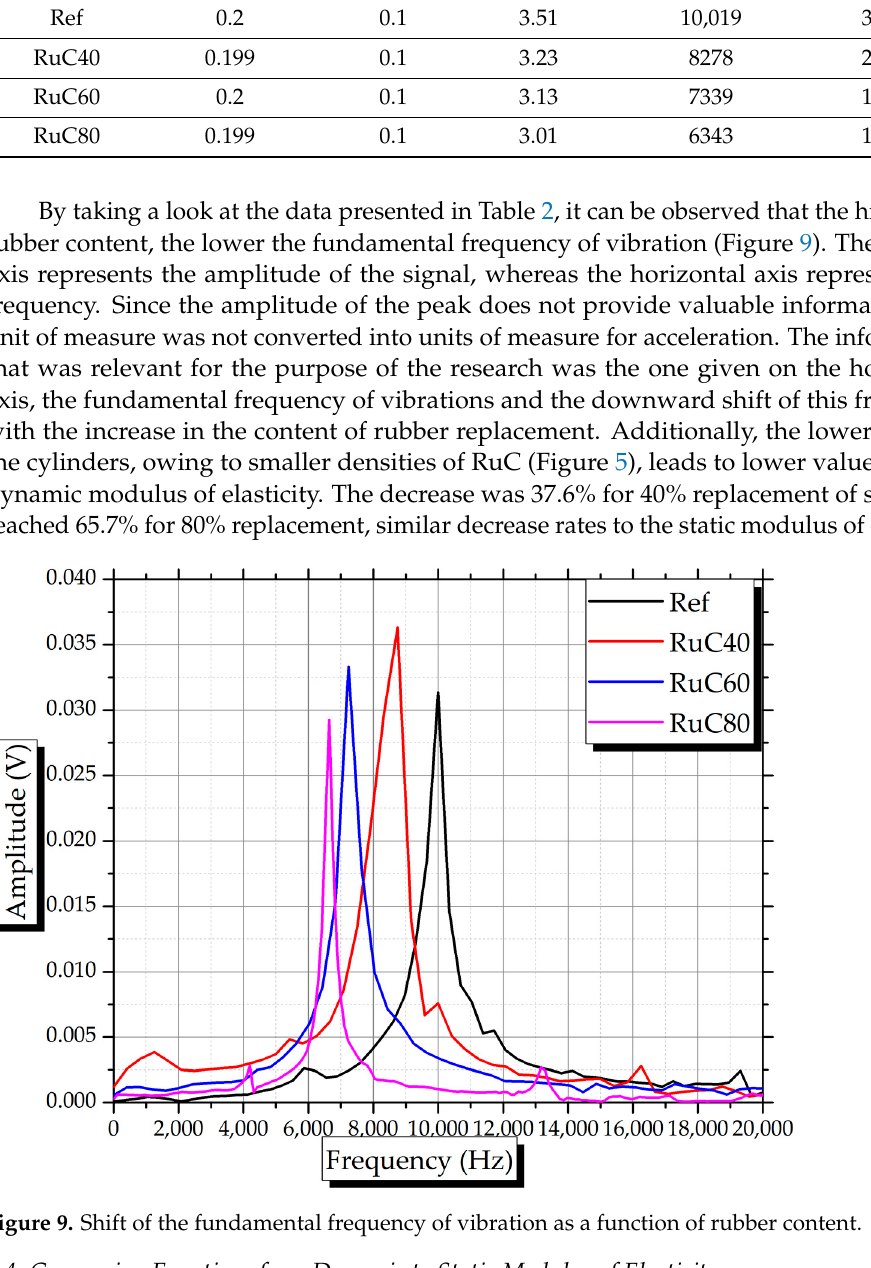
Table 2. Dynamic modulus.